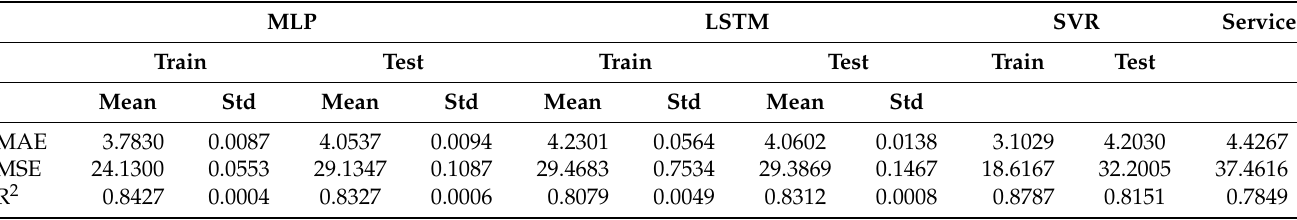
Table 11. Comparison of the effectiveness of the MLP model, two other models, and the weather service in forecasting the mean daily atmospheric pressure.